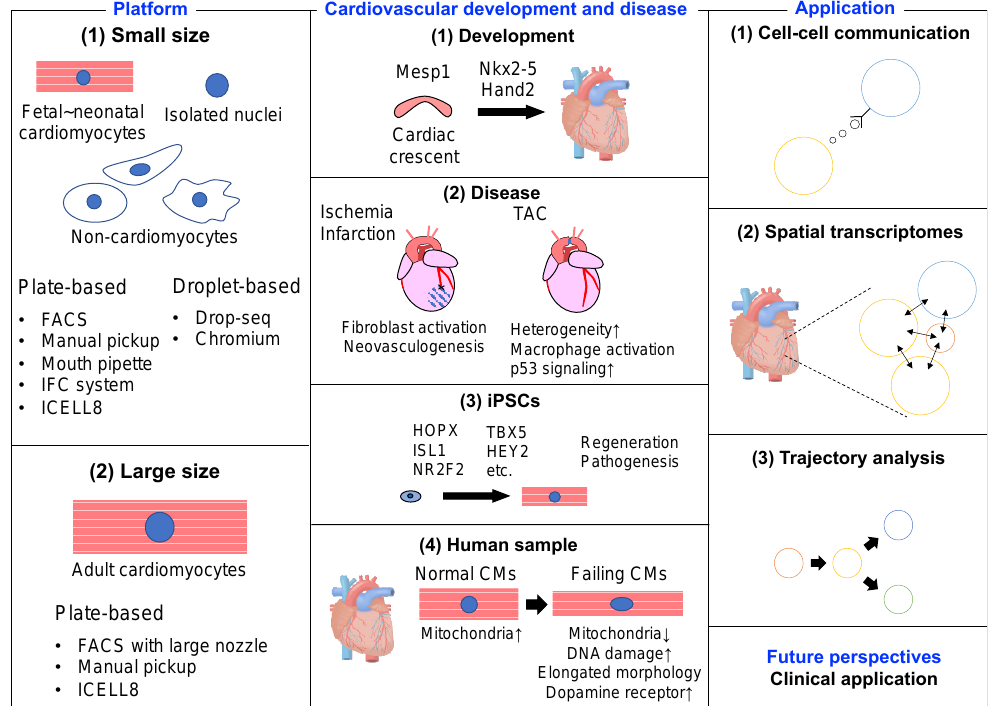
Figure 1. Summary figure of single-cell RNA-sequencing in the heart.